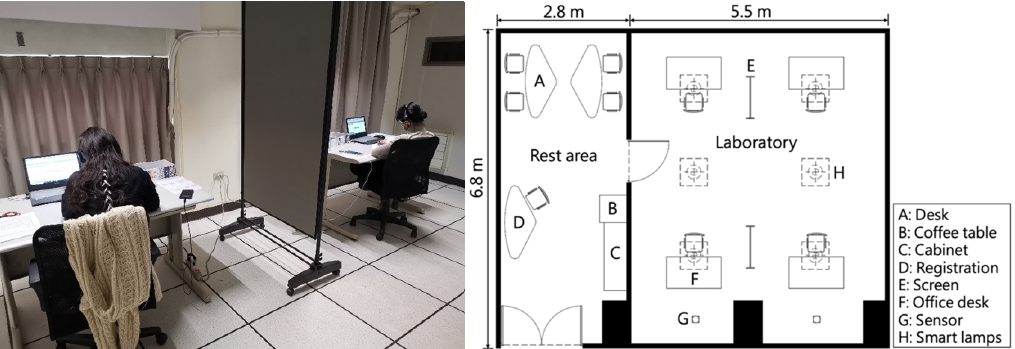
Figure 2. The picture and plan of the laboratory.